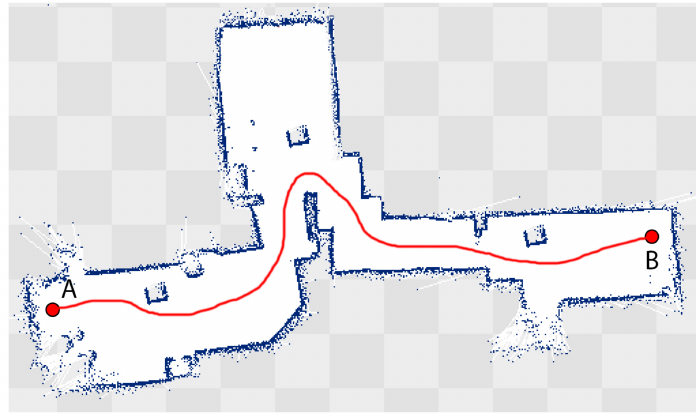
Figure 12. Lidar-based indoor map of the hospital and path of a telepresence robot.